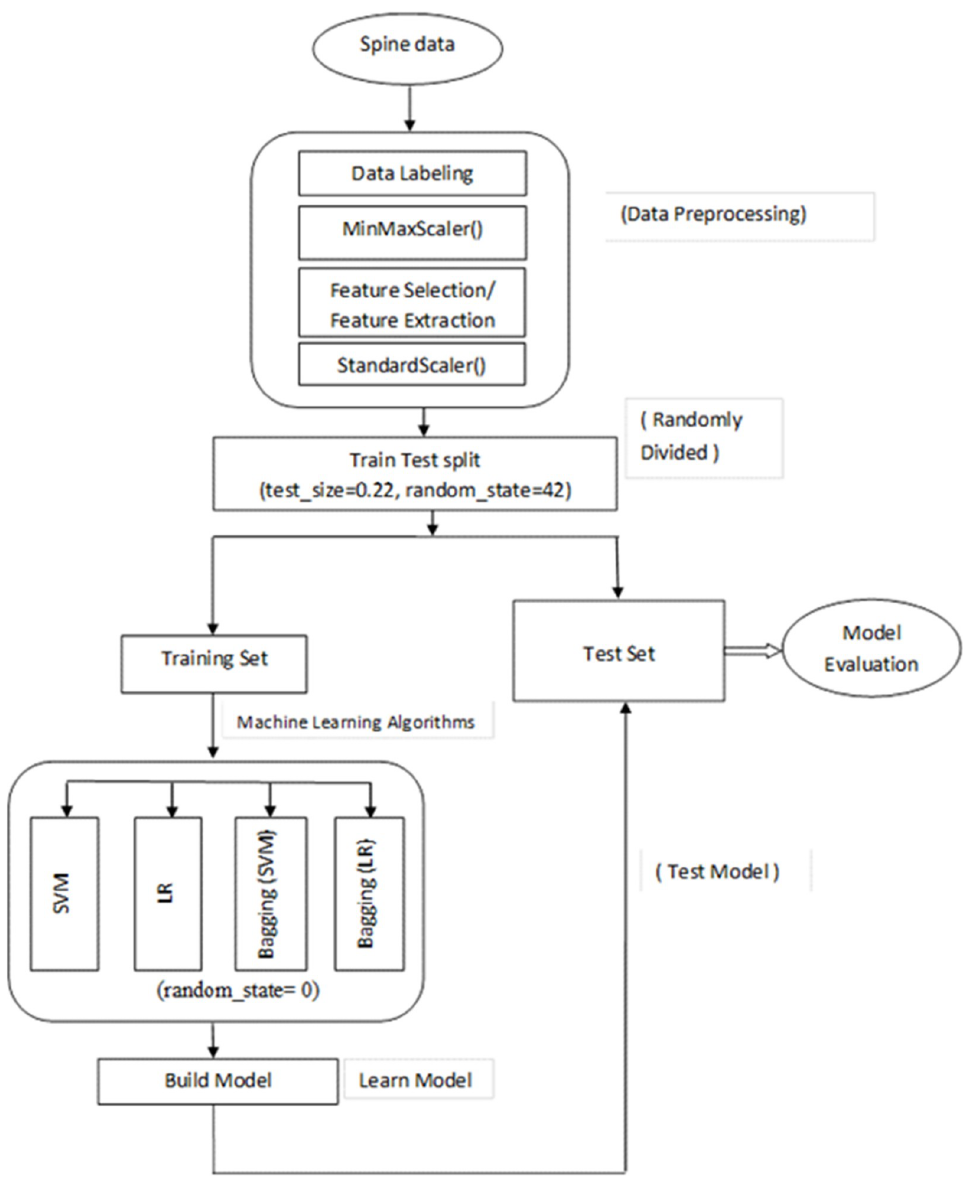
Fig 2. Work flow